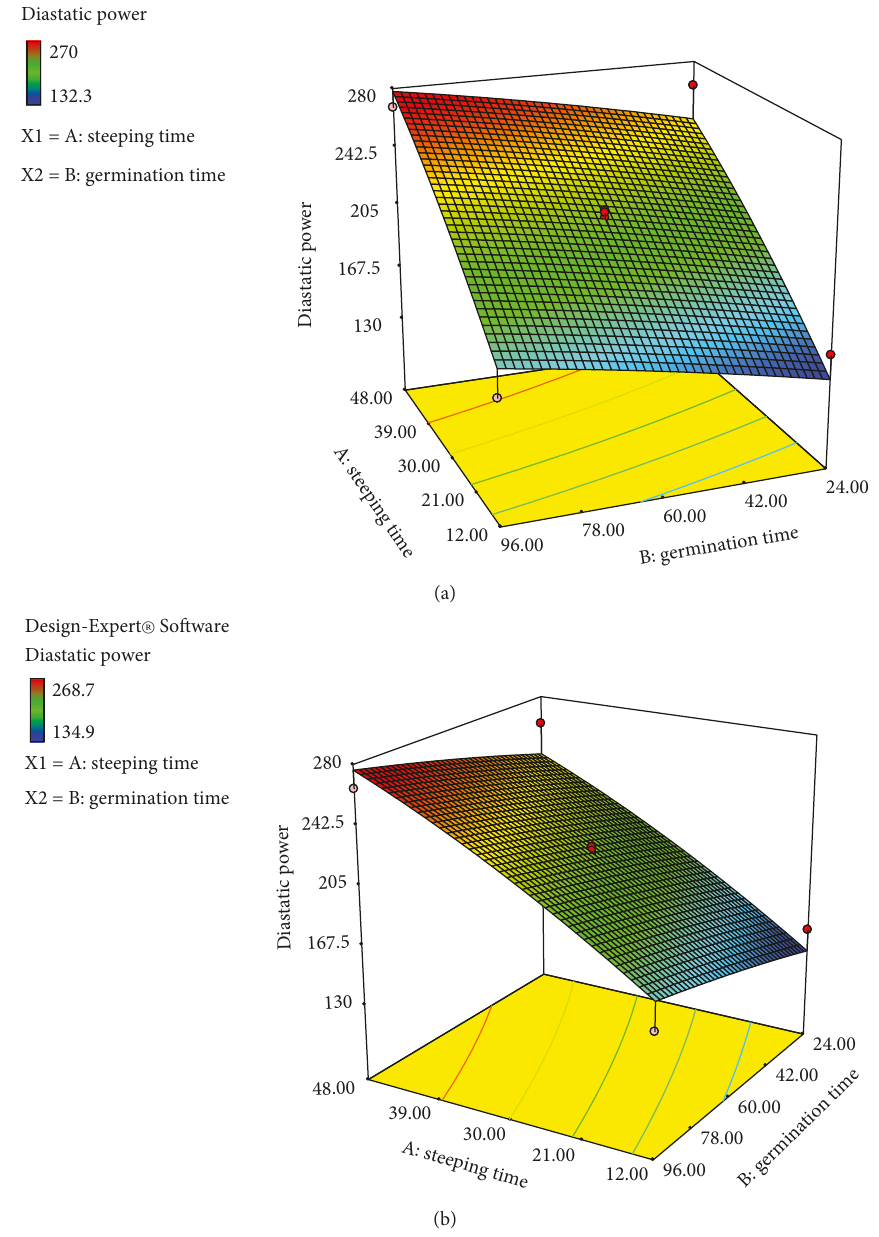
Figure 3: Contour plots for steeping time and germination time on diastatic power of (a) barley malt and (b) quinoa